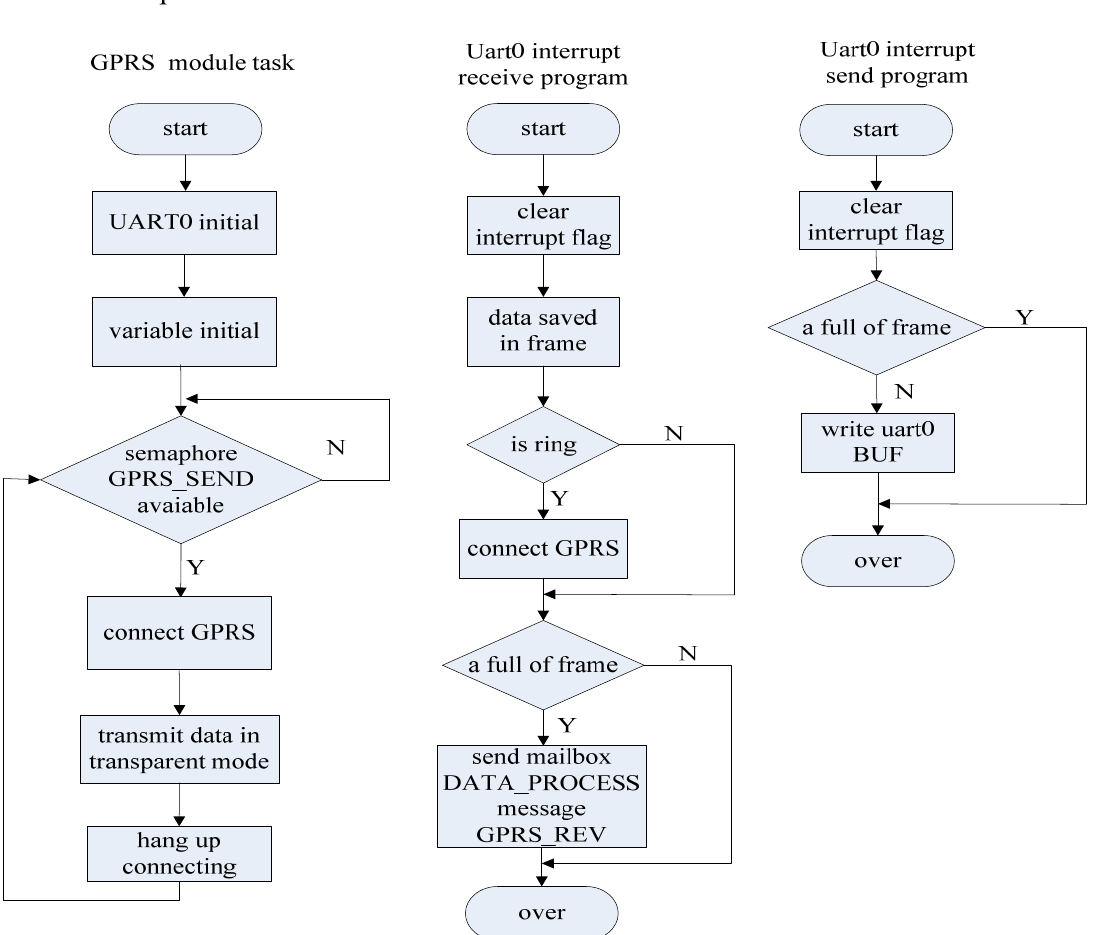
Figure 18. The flow chart of GPRS module communication task and the corresponding serial interrupt service